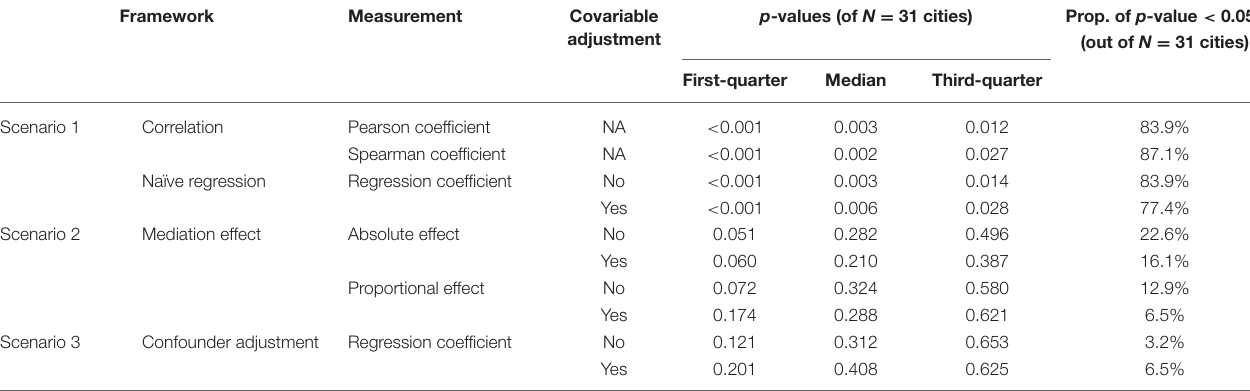
TABLE 1 | Summary of p -values of all N = 31 selected cities, and comparison of the percentage distribution of p -values by different measurements across the 31 cities.